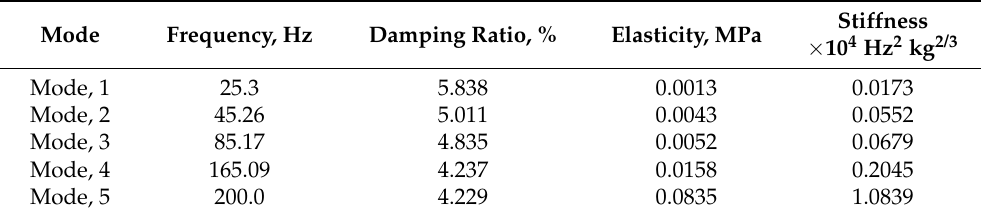
Table 4. Determining the natural frequency, damping ratio, elasticity, and stiffness factor for can- taloupe fruit for the paper pulp tray packing method.